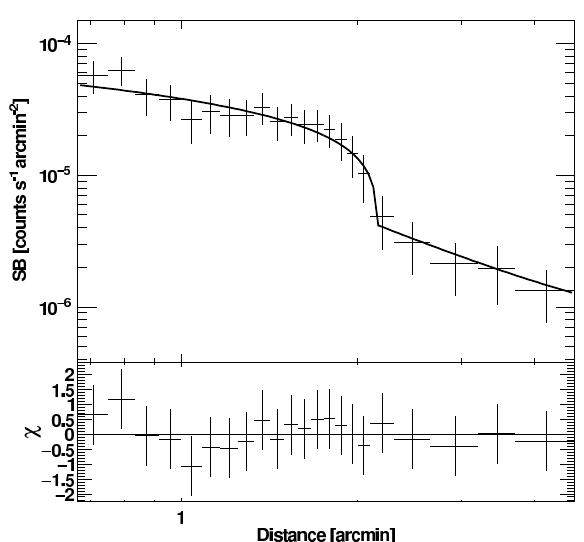
Figure 6. The surface brightness profile across the surface brightness edge of the RXC J1053.7+5453 from [7]. The best fit model written in the text is displayed with the black